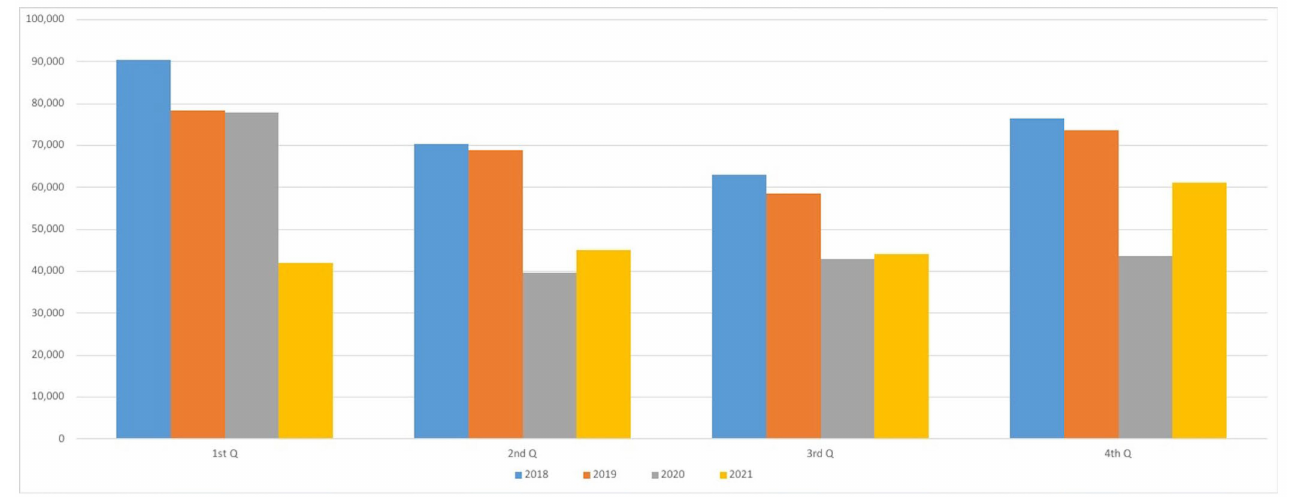
Figure 2. Number of patients treated with an antibiotic between the years 2018 and 2021